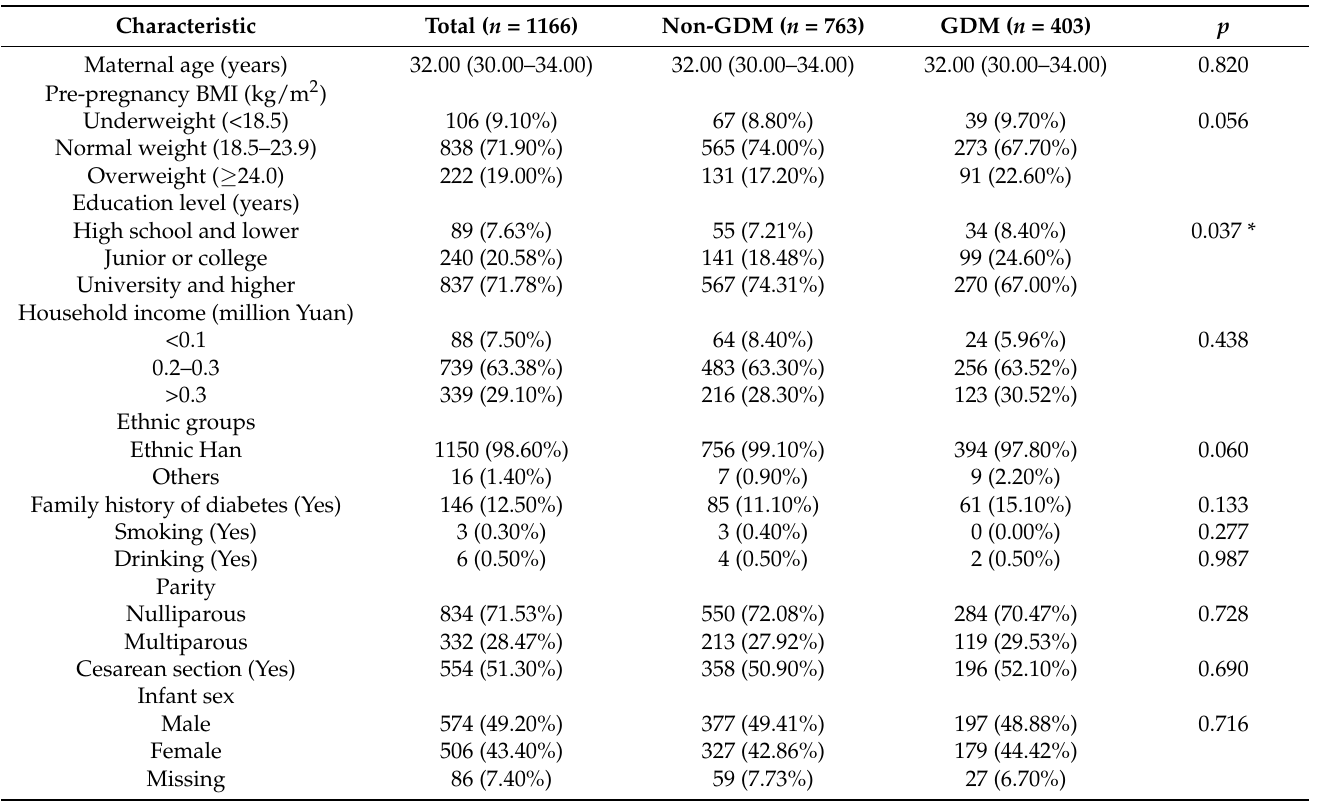
Table 1. Characteristics of the study population.